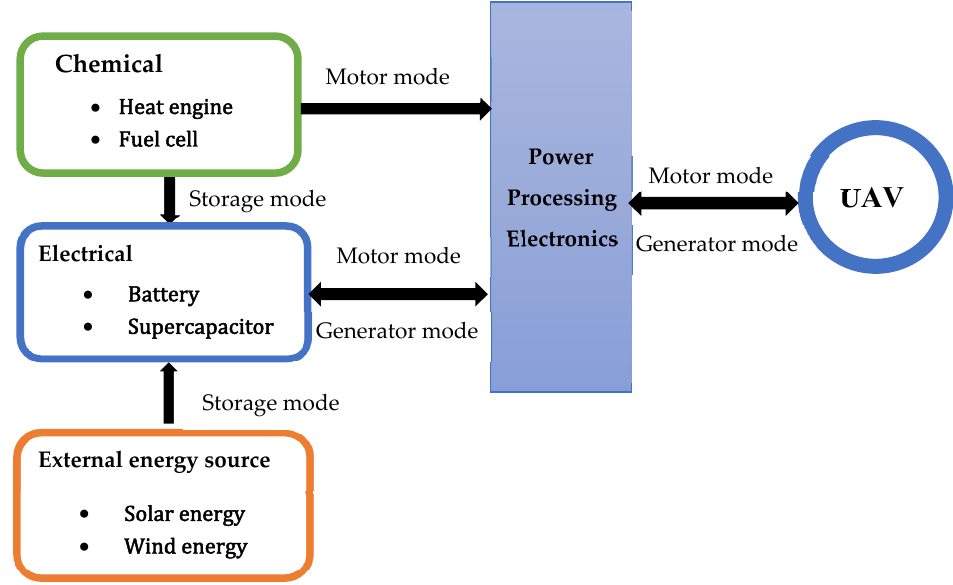
Figure 9. Power supplies in a UAV.